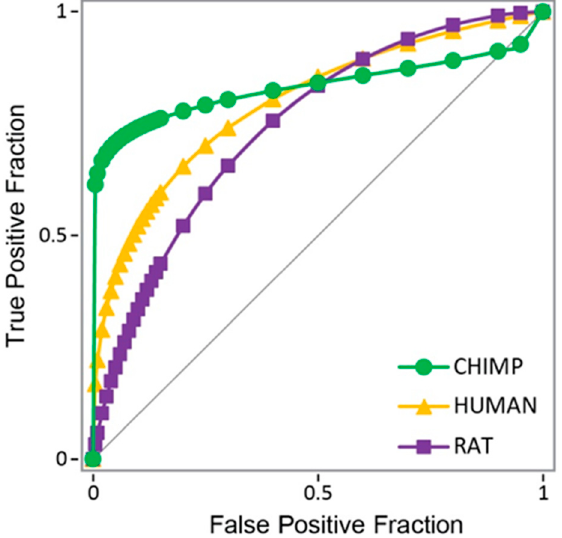
Figure 1. Receiver-operator curves for docking to the human (in yellow), rat (in purple), and chimp (in green) androgen receptor as compared to a random pick (diagonal line). Chimp AUC = 0.832; human AUC = 0.797; and rat AUC = 0.744.